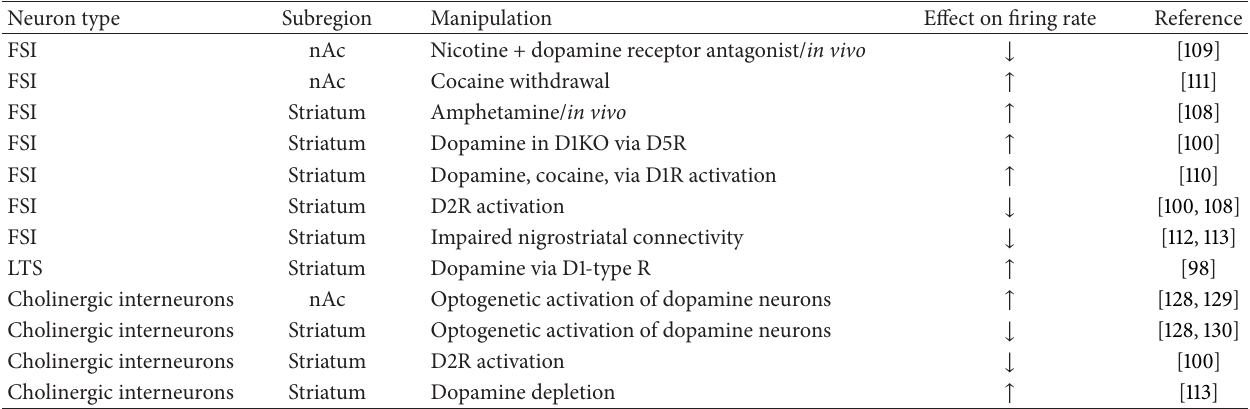
Table 1: Dopaminergic regulation of striatal